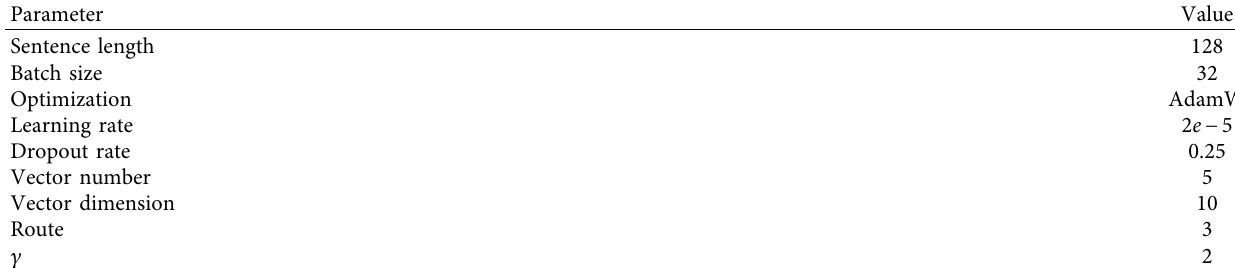
Table 2: The parameter settings of our